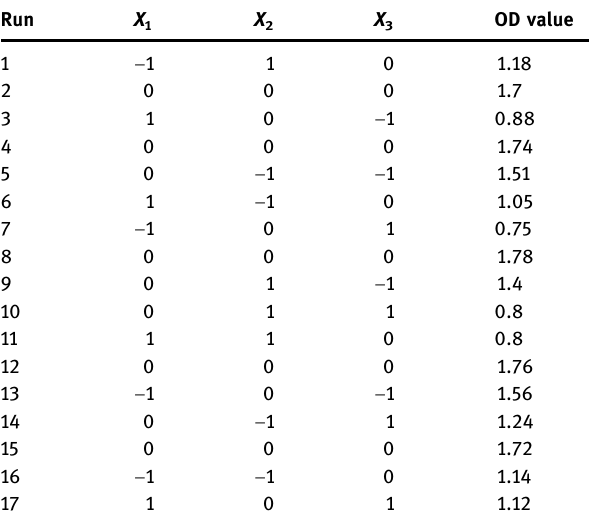
Table 5: Box – Behknen design matrix and experimental results Run